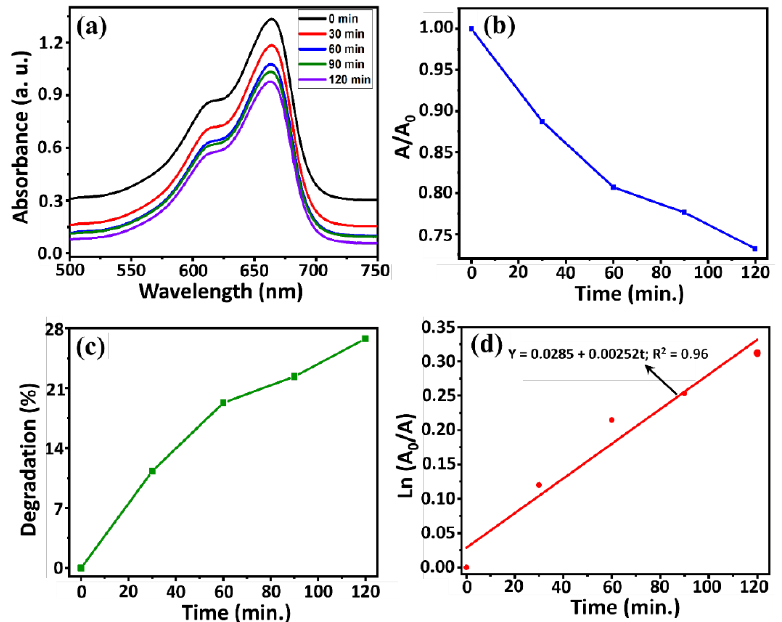
Figure 10. Photodegradation of MB under visible light irradiation; change of absorbance with time ( a ), change of normalized absorbance with time ( b ), degradation percentage ( c ), and kinetics plot ( d ). The half-life of the reaction (t 1/2 ), the time it takes for the initial concentration of the dye to decrease by half, is shown in Equation